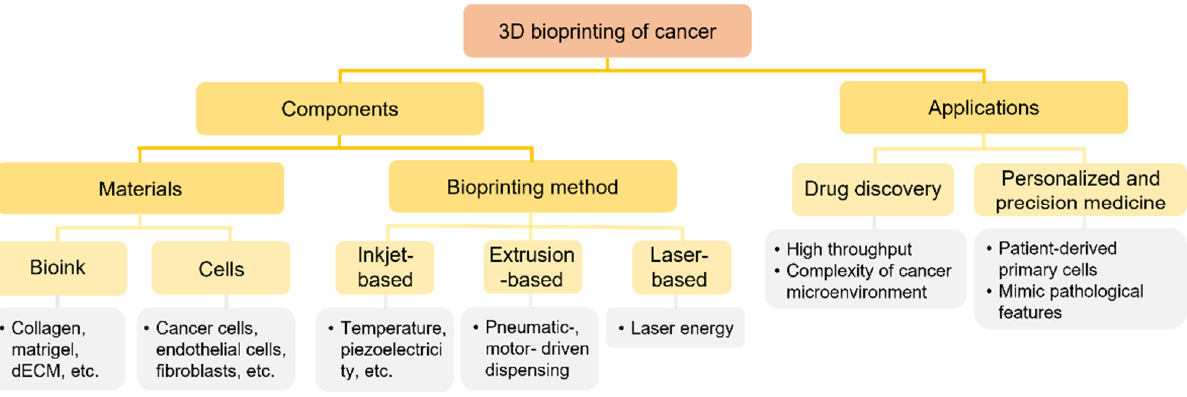
Figure 1. Tree diagram depicting the three-dimensional (3D) bioprinting process for cancer systems.